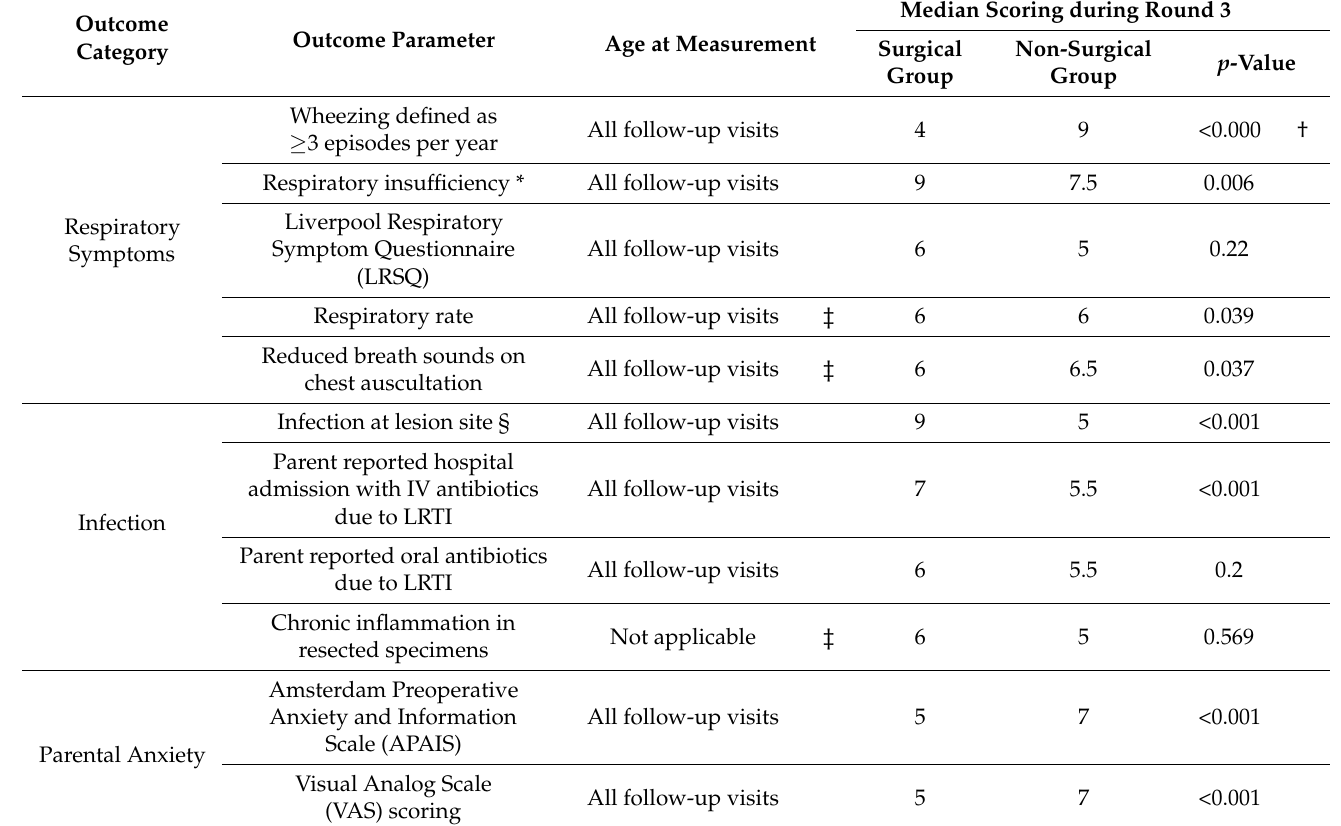
Table 1. Summary of outcome parameter scoring per stakeholder group during Delphi